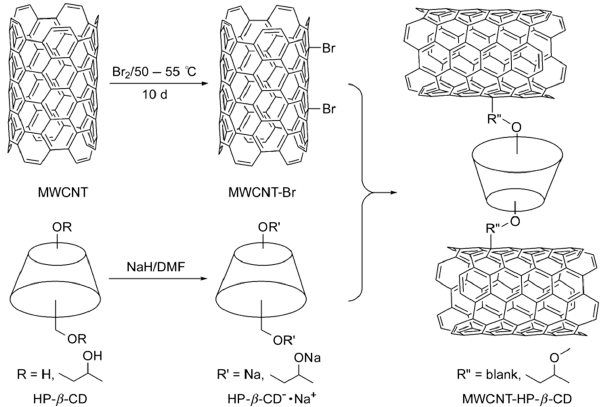
Figure 9. Schematic presentation of preparation of HP- β -CD modified MWCNTs. The figure and the caption have been adapted with permission from [102] , Copyright © 2011 Wiley.